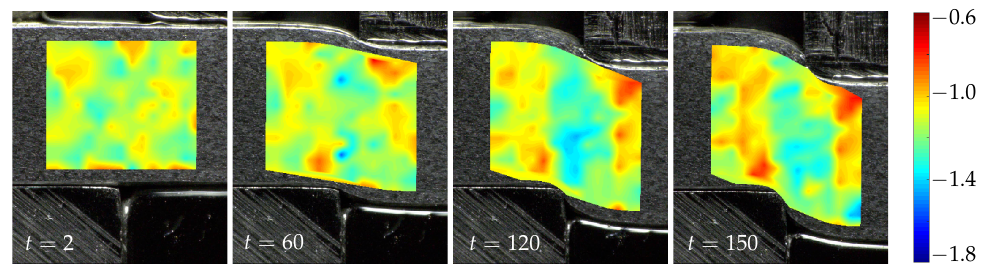
Figure 9. Temporal evaluation of scale exponent fields during shear cutting.